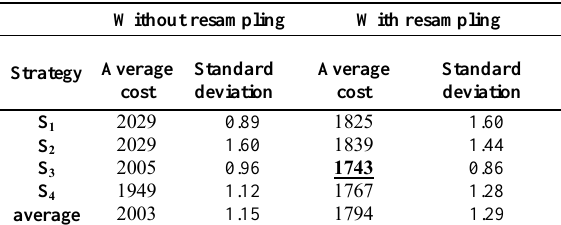
Table 5. Results of proposed methodology (cost-sensitive learning).